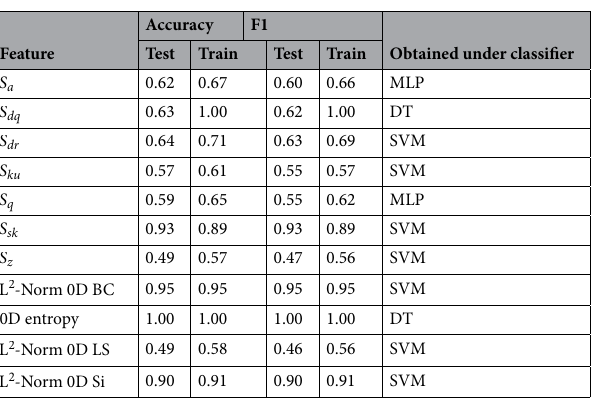
Table 5. Mean accuracy and mean F1 for the best performing classifier on either conventional parameters or scalar persistent-based parameters in a single feature classification.